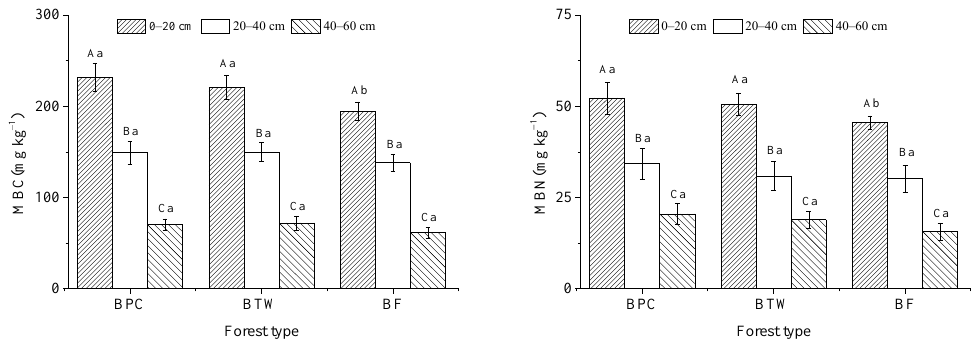
Figure 2. MBC and MBN concentrations in BPC, BTW, and BF. Capital letters indicate the differences between different soil depths in the same forest type, and lowercase letters indicate the differences between different forest types at the same soil depth. BF, BPC, and BTW represent pure moso bamboo forest, bamboo forest interplanted with Phoebe chekiangensis , and bamboo forest interplanted with Taxus wallichiana var. maireii, respectively.